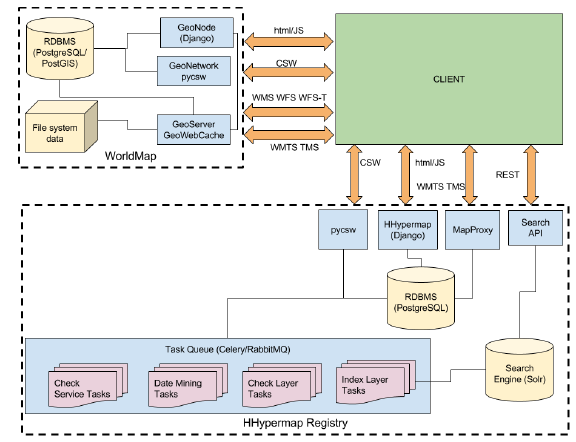
Figure 3. Architecture of the